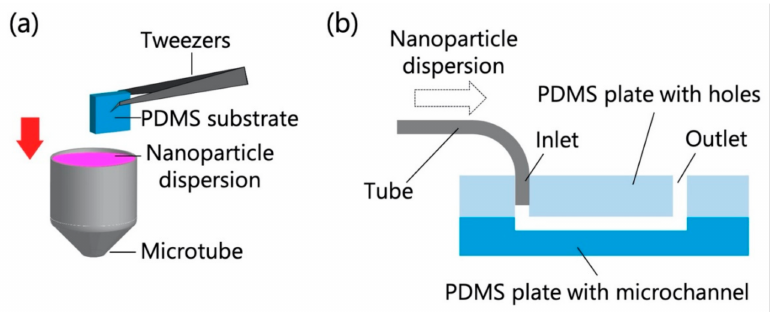
Figure 1. Schematics of particle adsorption tests for ( a ) the polydimethylsiloxane (PDMS)-based substrate and ( b ) the PDMS-based microchannel (30 mm long, 3 mm wide, and 100 µ m